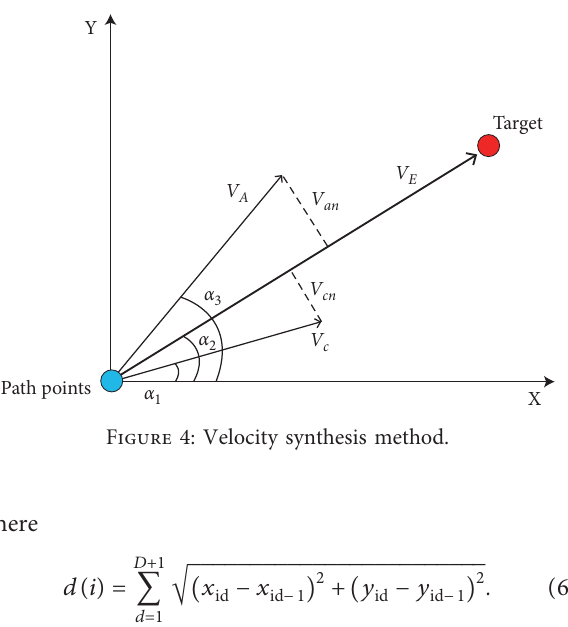
Obtain individual optimal and global optimal Figure 3: PSO algorithm applied in path planning.